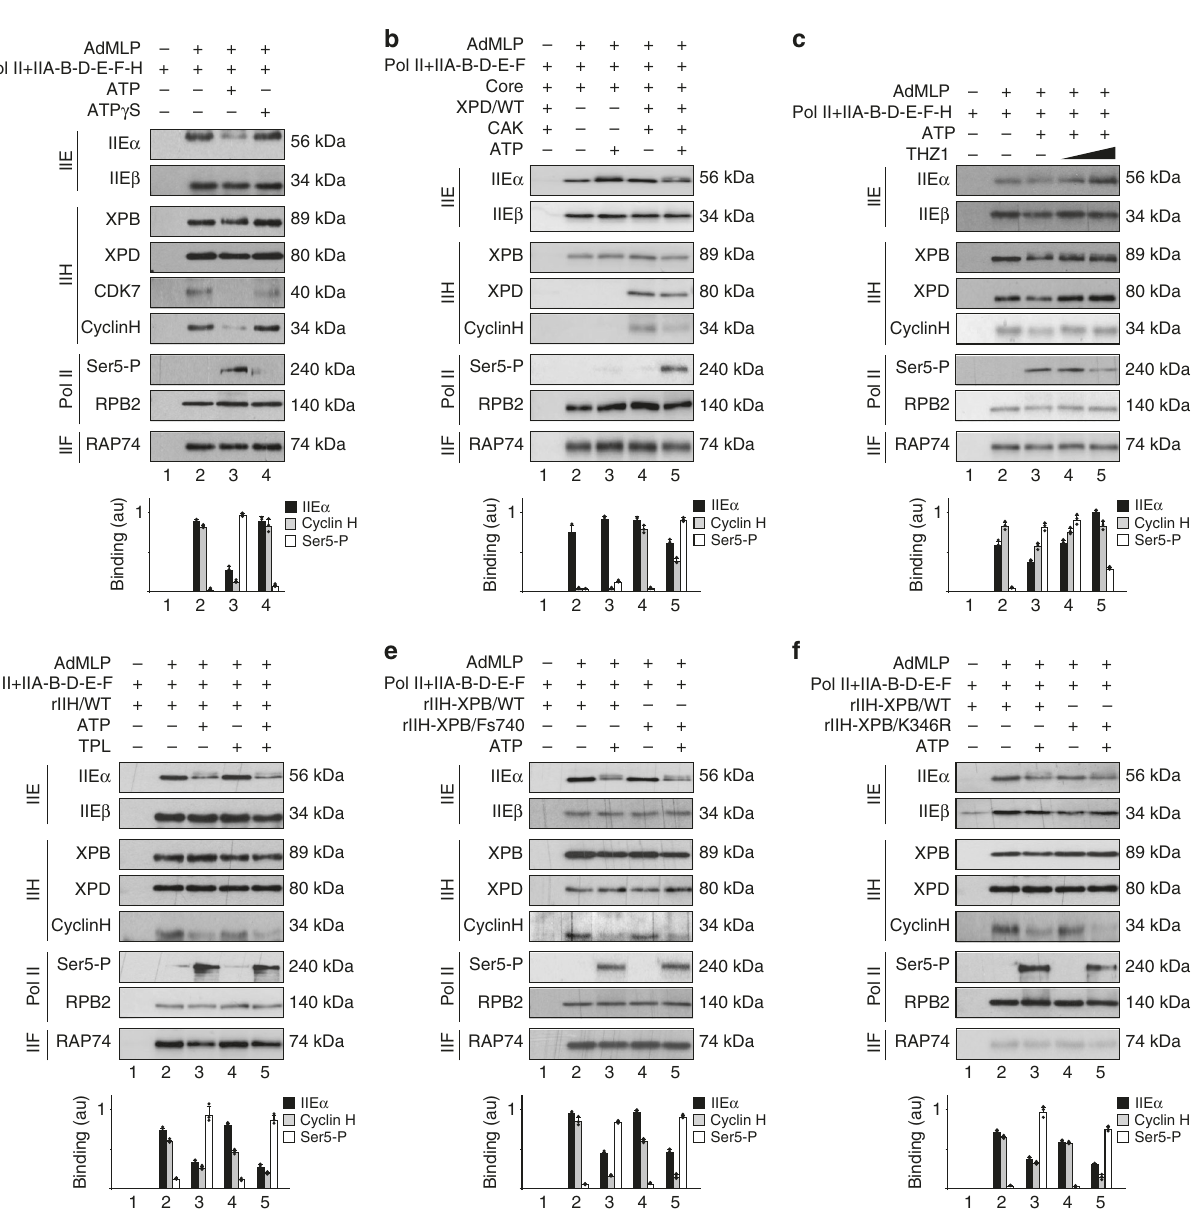
Fig. 4 TFIIE α and CAK releases and Pol II phosphorylation occur before DNA opening. a Streptavidin magnetic beads were incubated ( + ) with biotinylated AdMLP, Pol II, TFIIA, TFIIB, TFIID (TBP), rIIE αβ /WT, TFIIF and rIIH/WT, in presence of either ATP (200 μ M) or ATP γ S (200 μ M). After washes, the binding of various factors has been evaluated by immunoblotting. The immunoblot signals for TFIIE α , CyclinH, and Ser5-P were quanti fi ed ( n = 3, means ± s.d.) and plotted in arbitrary units (a.u.). The results are representative of three independent experiments. b Streptavidin magnetic beads were incubated (when indicated, + ) with biotinylated AdMLP, Pol II, TFIIA, TFIIB, TFIID (TBP), rIIE αβ /WT, TFIIF, the Core-TFIIH, XPD/WT, and the CAK, in presence of ATP (200 μ M). After washes, immunoblot analysis was done for different proteins. The immunoblot signals for TFIIE α , CyclinH, and Ser5-P were quanti fi ed ( n = 3, means ± s.d.) and plotted in arbitrary units (a.u.). The results are representative of three independent experiments. c Streptavidin magnetic beads were incubated ( + ) with biotinylated AdMLP, Pol II, TFIIA, TFIIB, TFIID (TBP), rIIE αβ /WT, TFIIF, and rIIH/WT, in presence of ATP (200 μ M) and THZ1 (1 and 10 μ M). The immunoblot signals for TFIIE α , CyclinH, and Ser5-P were quanti fi ed ( n = 3, means ± s.d.) and plotted in arbitrary units (a.u.). The results are representative of three independent experiments. d When indicated ( + ), biotinylated AdMLP bound to streptavidin magnetic beads were preincubated 20min (at 25 °C) with the general transcription machinery (Pol II, TFIIA, TFIIB, TFIID (TBP), rIIE αβ /WT, TFIIF, and rIIH/WT) in presence of Triptolide